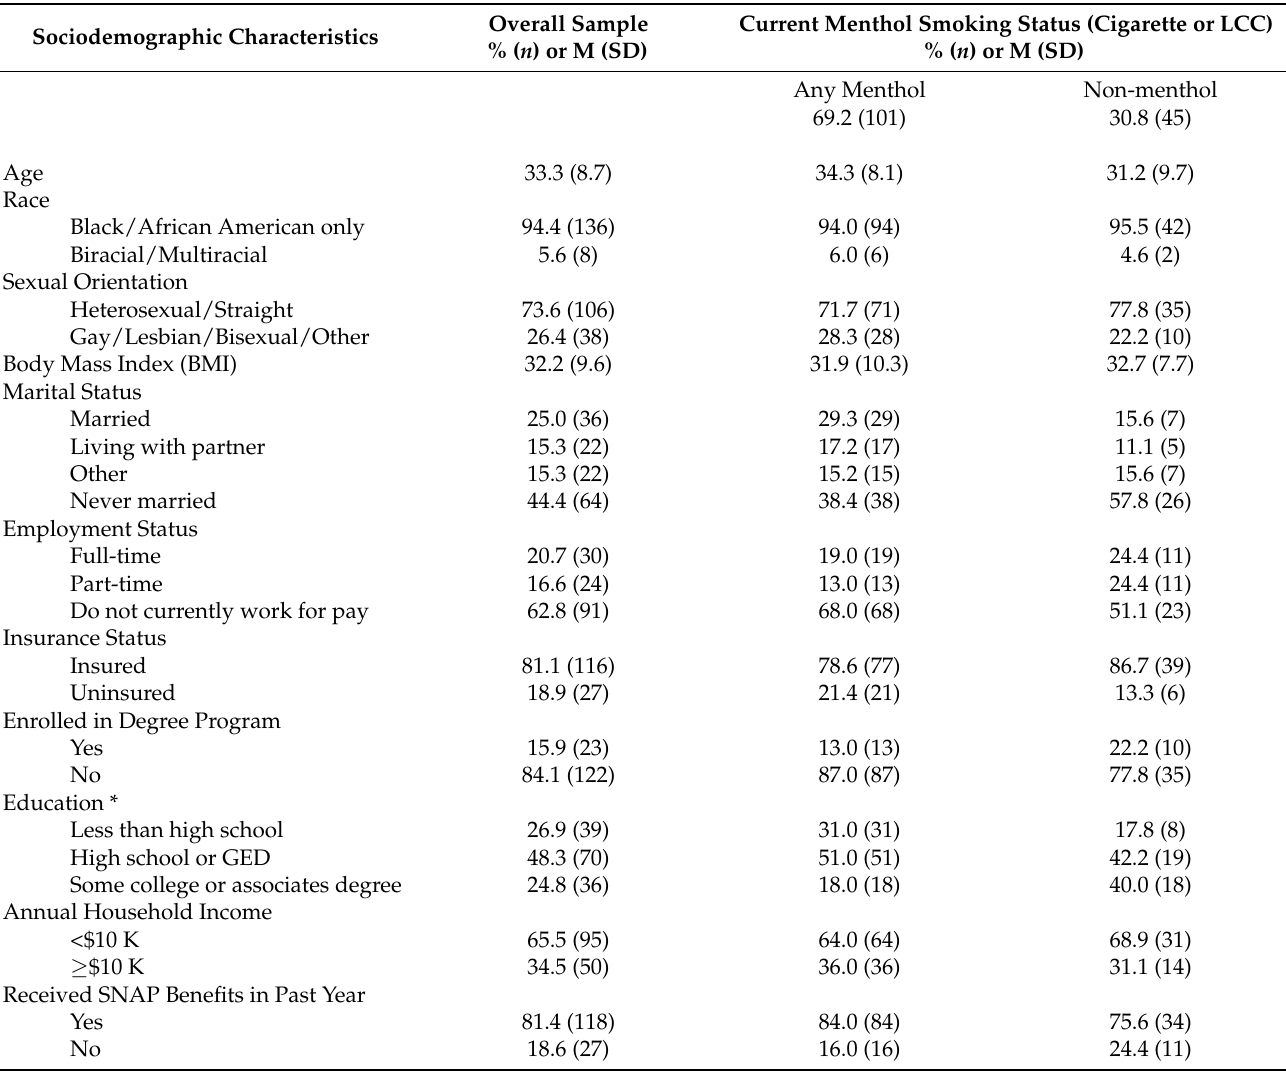
Table 1. Sociodemographic Characteristics of Black/African American Women Smokers by Menthol Smoking Status (N = 146). Sociodemographic